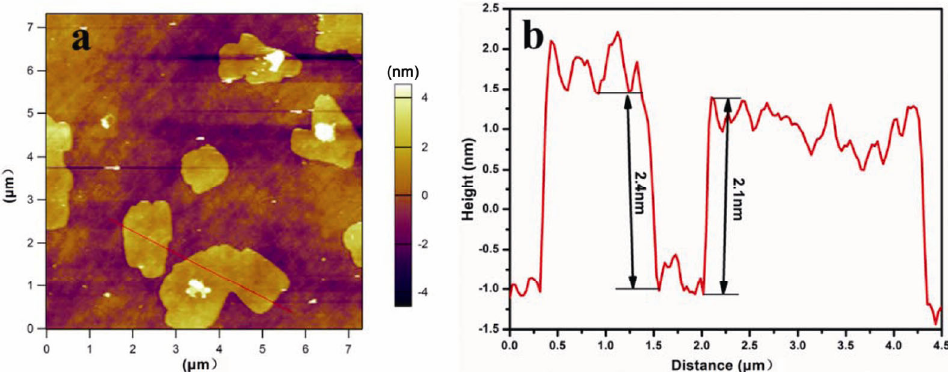
Fig. 5 (a) Tapping mode AFM image and (b) corresponding height profile of the